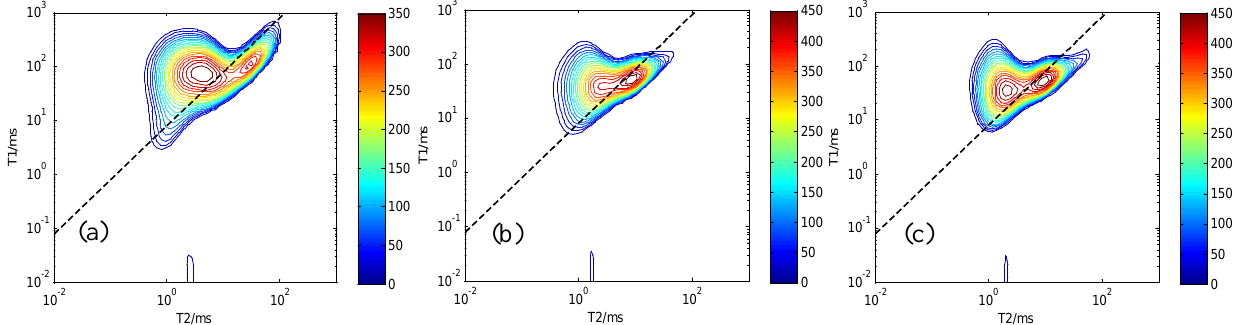
Figure 11. 2D NMR spectrum of Core J1 at three different states (( a ) saturated oil; ( b ) after air flooding; ( c ) after three rounds of air HnP).